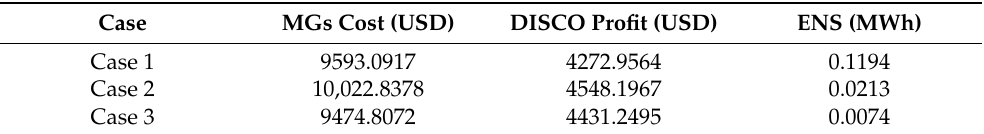
Table 2. Comparison of the results for different cases.